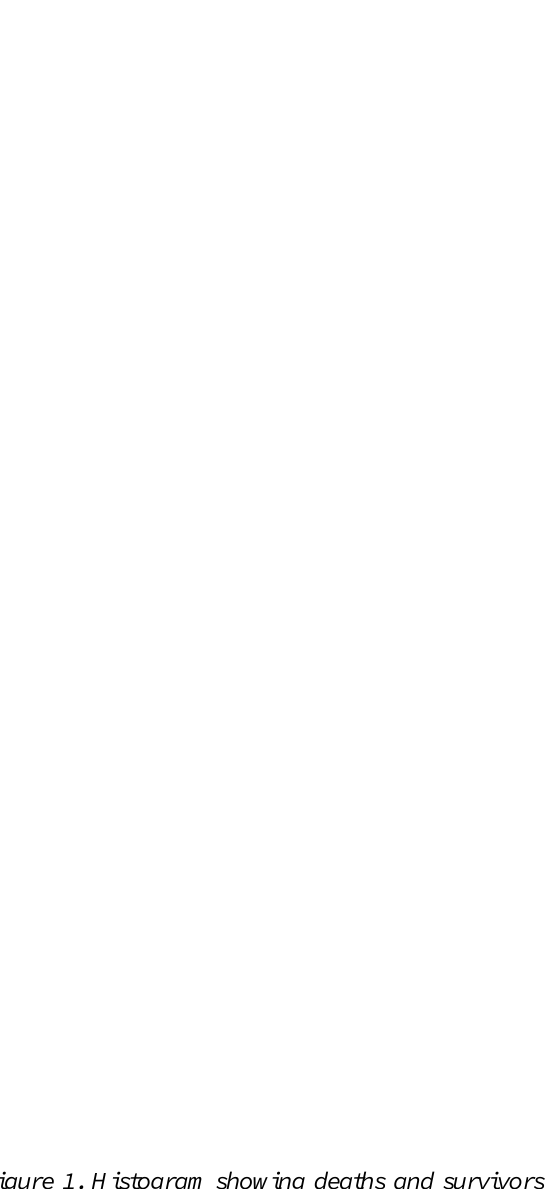
Figure 1. Histogram showing deaths and survivors as a proportion of total cases within consecutive 3 month blocks. Blocks A and B correspond to Group 1 patients, blocks C and D represent the Group 2 patients. Group E represents an incomplete 3 month block with no mortality immediately